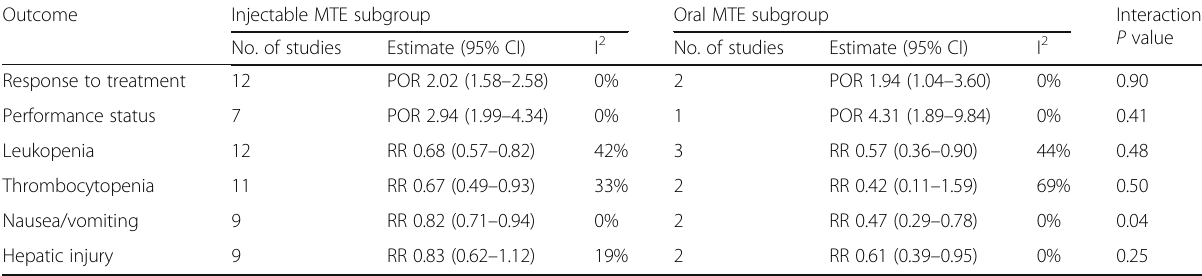
Table 2 Subgroup analysis stratified by injectable and oral Marsdenia tenacissima extract Outcome